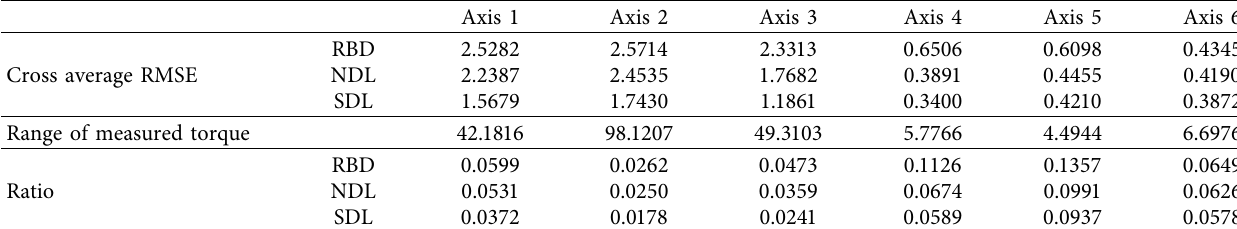
Figure 6: All axes prediction results. Table 3: Comparative analysis of prediction performance of different joint